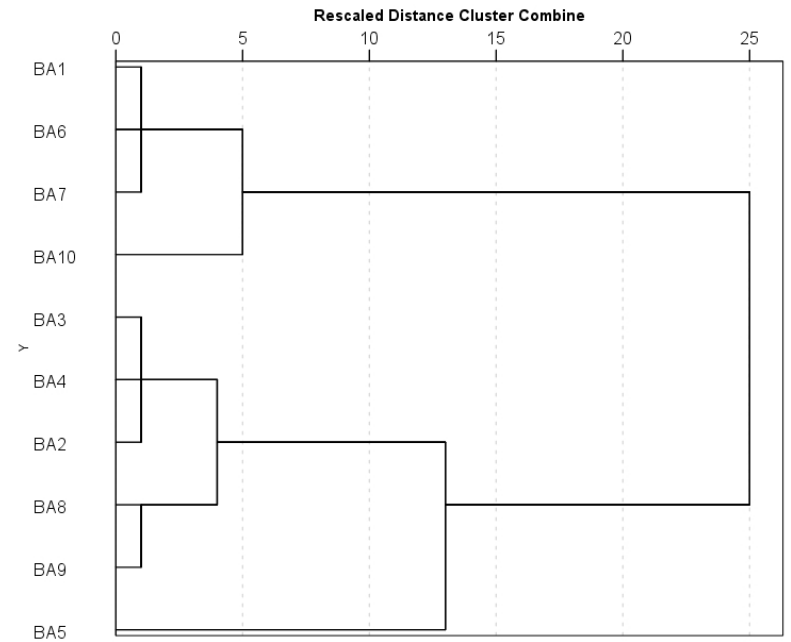
Figure 10. Dendrogram of hierarchical cluster analysis based on the location of the monitoring wells in 2012.